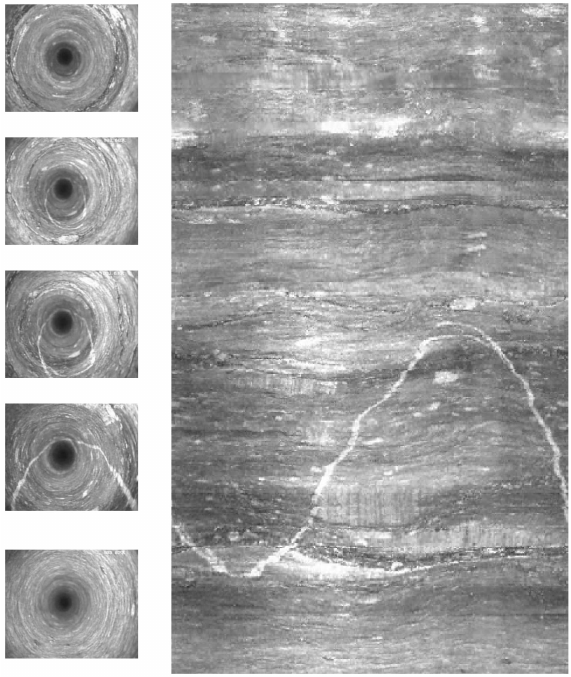
Figure 24. Borehole-wall cylindrical panorama generated from the second